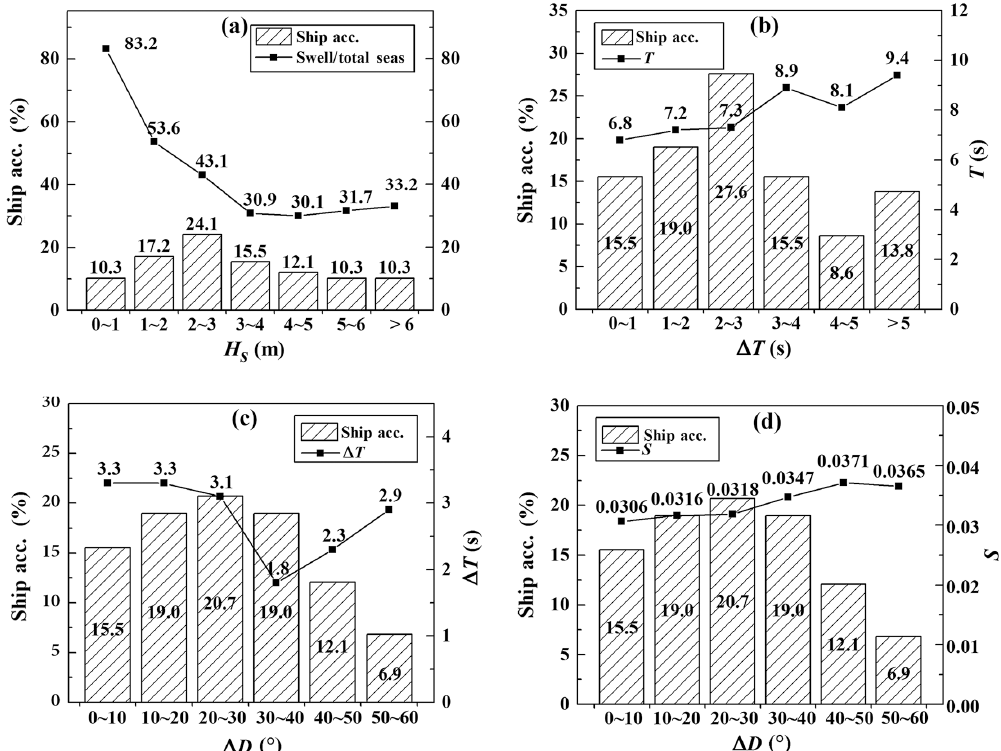
Figure 3. Incidence rate of ship accidents: (a) at different significant wave heights (H s , bar chart) and the proportional change in swell energy in the total sea (polygonal line); (b) with wave period differences ( (cid:49)T , bar chart) and the mean wave period ( T , polygonal line); (c) with wave direction differences ( (cid:49) D) and (cid:49)T ; and (d) with (cid:49) D and the value of the wave steepness of the total sea ( S